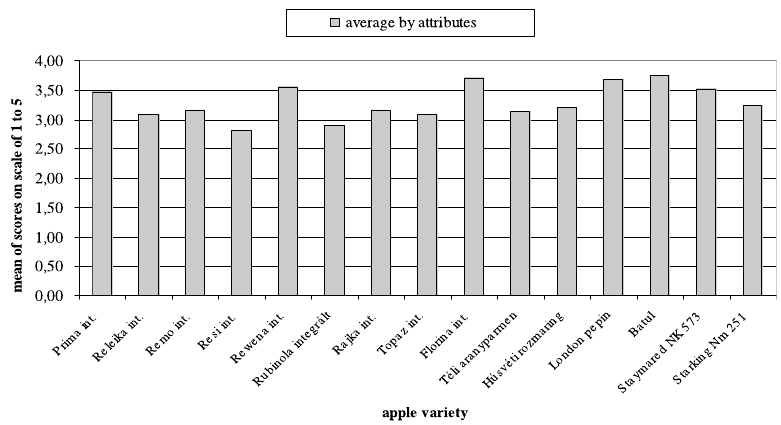
Figure 6: The mean combined scores of the five independent properties evaluated by the same